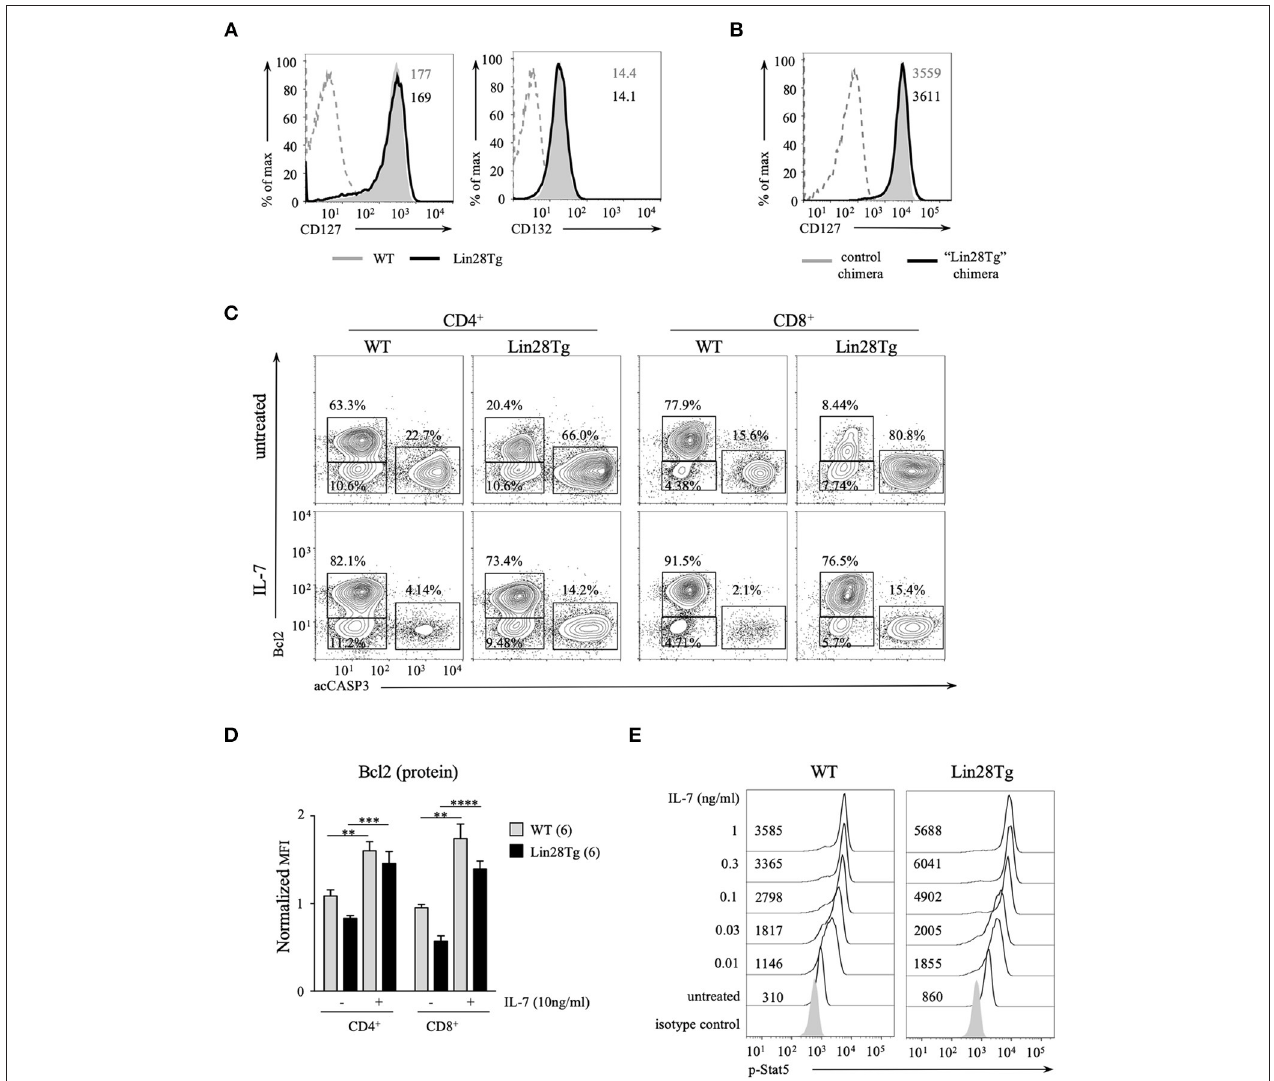
FIGURE 6 | IL-7 receptor signaling is normal in let-7-deficient T cells. (A) Surface expression of CD127 and CD132 on CD8T cells from lymph nodes of P14 + Rag2KO wild type and Lin28Tg mice. MFIs of CD127 and CD132 are shown. Dashed histogram shows isotype control. (B) Surface expression of CD127 on CD8T cells from lymph nodes of control and “Lin28Tg” mixed BM chimeras. MFIs of CD127 are shown. Dashed histogram shows isotype control. (C) Intracellular staining for active Bcl2 and active Caspase-3 in CD4 and CD8 lymph node T cells from wild type and Lin28Tg mice cultured for 18h in the presence of 10ng/ml IL-7. (D) MFI of Bcl2 in acCasp3 negative populations in CD4 and CD8 lymph node T cells from (C) normalized to + 4 ◦ C cultures. (E) Phospho-Stat5 staining in CD8T cells from lymph nodes of P14 + Rag2KO wild type and Lin28Tg mice cultured with indicated concentrations of IL-7 for 30min. MFIs of p-Stat5 are shown. Data in (A,E) are from two independent staining experiments. Data in (B,C) are representative of three independent staining experiments. Data in D are displayed as mean ± SEM; ** p < 0.01, *** p < 0.001, **** p <